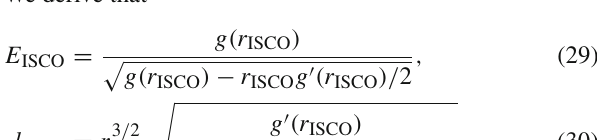
Fig. 4, the bottom and the top curves represent V eff in l ISCO and l MBO . It is shown that these curves have a sharp increase points of V eff are the dashed lines in Fig. 4. From the